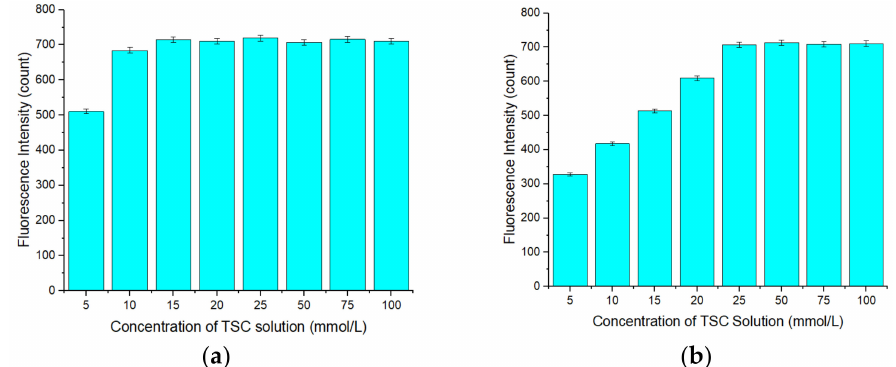
Figure 12. ( a ) Relationship between the fluorescence intensity of the restored QD solution and the concentration of thiosemicarbazide (TSC) solution added into a copper standard solution before detection. Concentration of TSC solution: 5–100 mmol / L. Concentration of copper standard solution before detection: 0.5 mol / L. Mix order: copper standard solution (5 µ L) → TSC solution (5 mL). Concentration of Tris-HCl bu ff er solution: 10 mmol / L. pH of Tris-HCl bu ff er solution: 8.5. Concentration of added QD solution: 5 µ mol / L. Concentration of APDC solution: 100 µ mol / L. Concentration of cadmium standard solution: 2.5 mmol / L. Concentration of mixed copper standard solution: 0.5 mmol / L. Concentration of TSC in mixed copper standard solution: 5–100 mmol / L. Addition order: Tris-HCl bu ff er solution (2 mL) → QD solution (0.4 mL) → APDC solution (0.52 mL) → cadmium standard solution (0.008 mL) → mixed copper standard solution (0.04 mL) → Tris-HCl bu ff er solution (1.032 mL). Excitation wavelength: 460 nm. Observation time: 3 min. * Mean of five measurements. ( b ) Relationship between the fluorescence intensity of the restored QD solution and the concentration of TSC solution added into a mercury standard solution before detection. Concentration of TSC solution: 5–100 mmol / L. Concentration of mercury standard solution before detection: 0.1 mol / L. Mix order: mercury standard solution (25 µ L) → TSC solution (5 mL). Concentration of Tris-HCl bu ff er solution: 10 mmol / L. pH of Tris-HCl bu ff er solution: 8.5. Concentration of added QD solution: 5 µ mol / L. Concentration of APDC solution: 100 µ mol / L. Concentration of cadmium standard solution: 2.5 mmol / L.